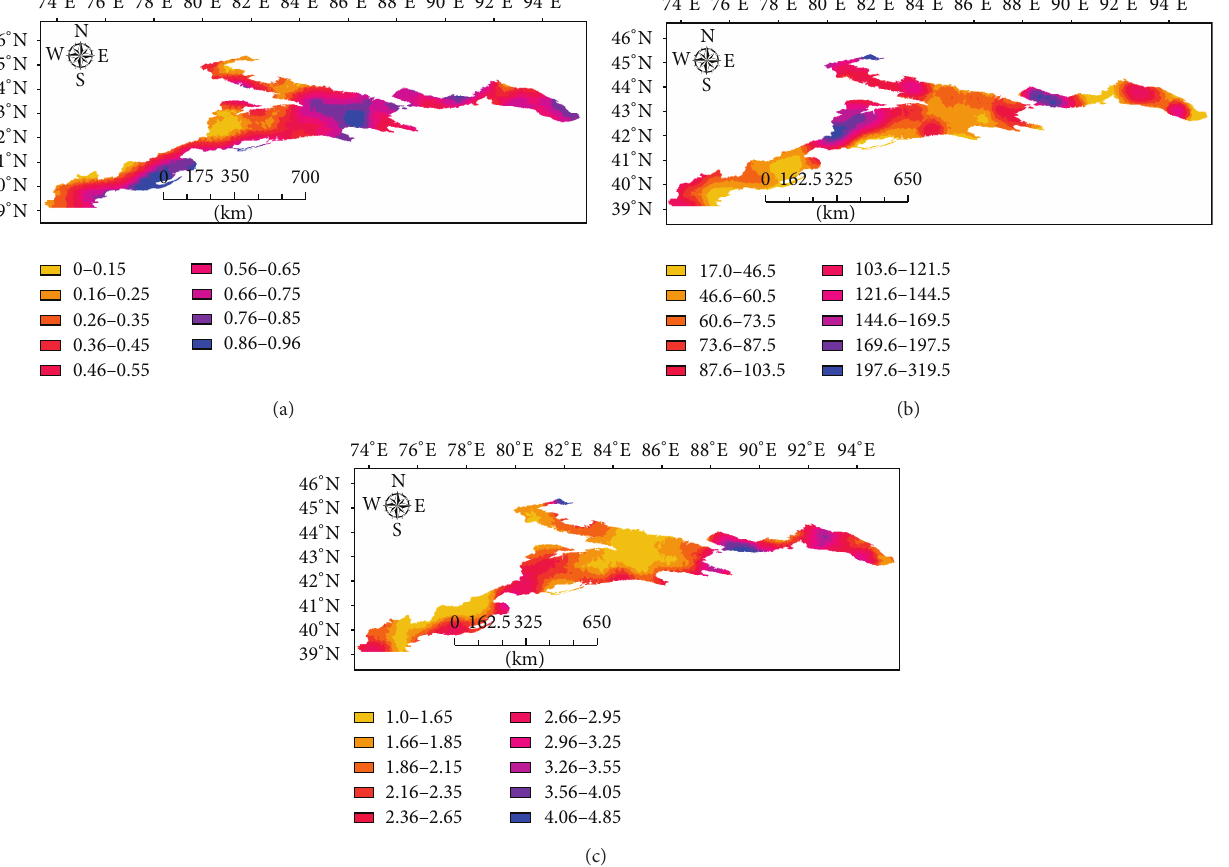
Figure 3: Spatial distribution of annual precipitation during 1998 ∼ 2007 produced by APHRODITE V1003R1 and TRMM 3B43 V6. (a) Correlation coefficient, (b) RMSE, and (c)